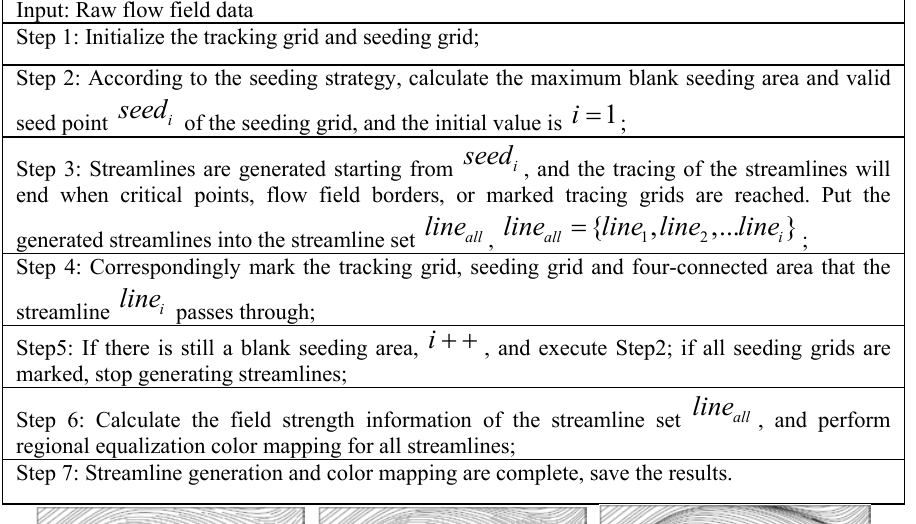
Table 1. Streamline color mapping enhancement algorithm based on double-layer grid control.